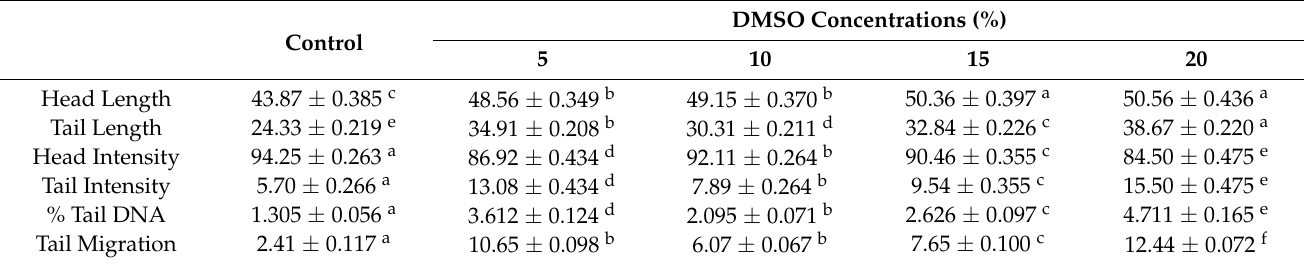
Table 3. Statistical analysis of the comet assay performed after cryopreservation of roughscale sole ( Clidoderma asperrimum ) sperm using various DMSO concentrations.